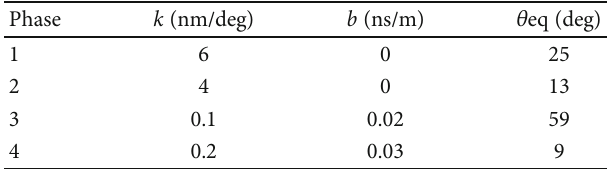
Figure 16: Experimental setup for the unlocked prosthetic leg test. Table 3: Coe ffi cient of controller for level walking.